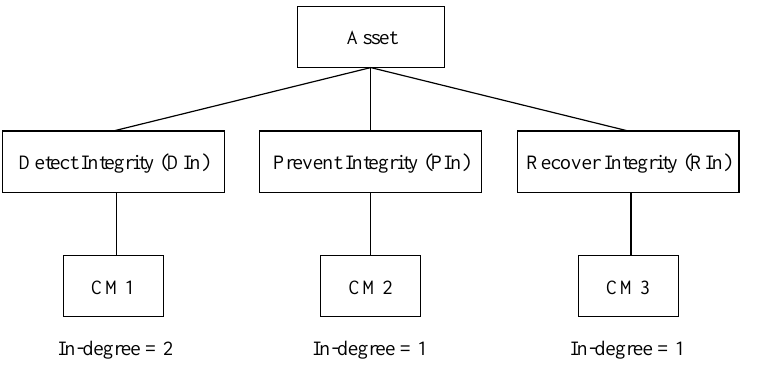
Figure 4. An in-degree example of a defense strategy. After obtaining the in-degree of each defense strategy, w x as shown in Figure 5. α = 0/0.2, denoting that the types of the current defense strategy and the previous defense strategy are not the same.